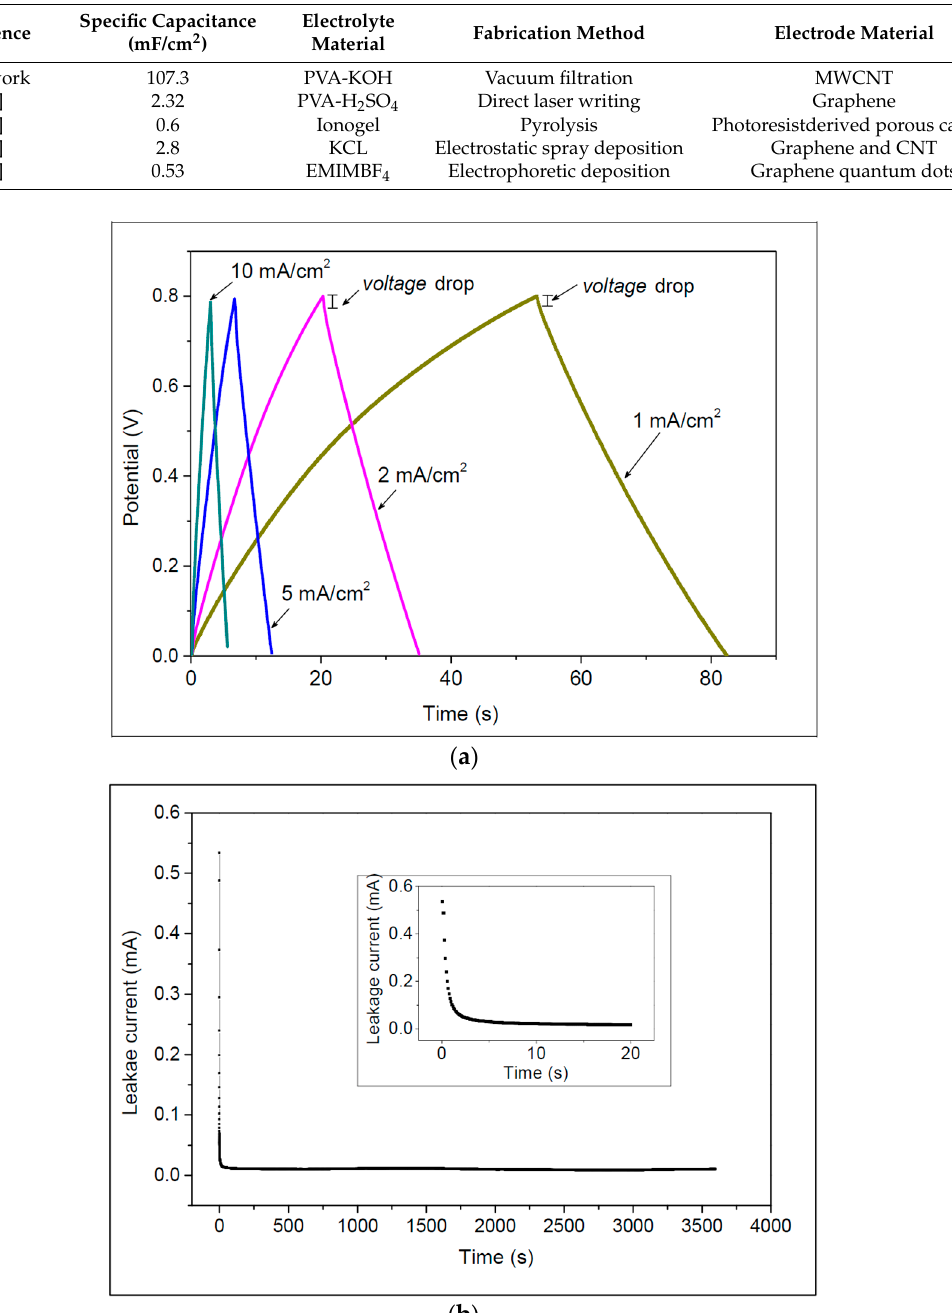
Figure 7. ( a ) Galvanostatic charge-discharge curves at various current densities. ( b ) Leakage current vs. time as the device was charged to 0.8 V and kept at 0.8 V for 3600 s. The charging current was 2 mA.